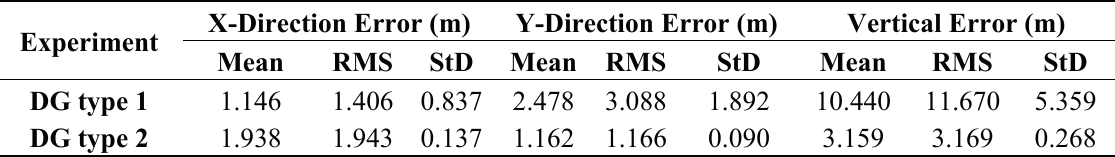
Table 4. Accuracy of direct georeferencing on